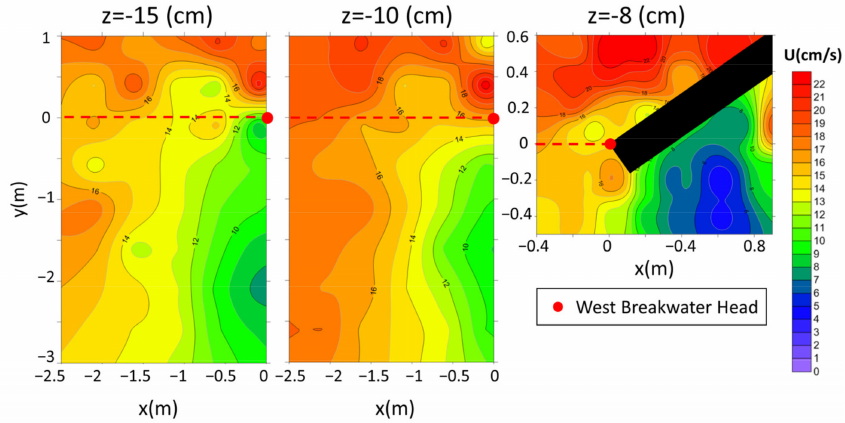
Figure 27. Max current velocity under the action of typhoon